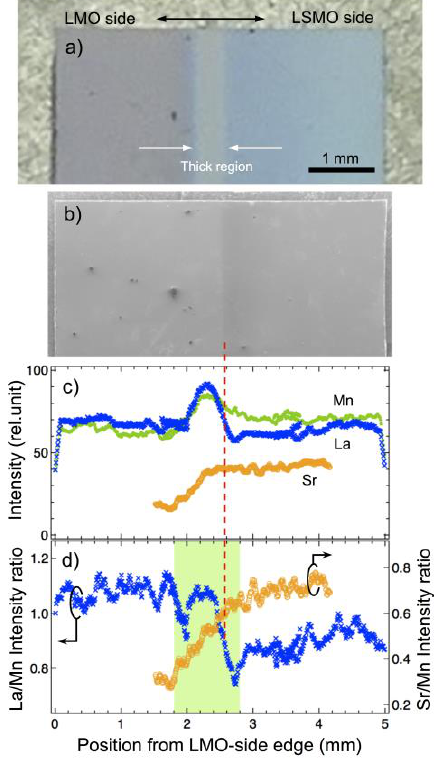
Figure 5. Optical image ( a ), SEM image ( b ), calibrated EDX signals of La, Sr, and Mn ( c ), and the EDX signals intensity ratio of La / Mn (crosses) and Sr / Mn (circles) ( d ) of a (1 − x )LaMnO 3 —x La 0.6 Sr 0.4 MnO 3 film. All panels are aligned so that the horizontal position in the images and the horizontal axes values in the graphs correspond to each other. Dashed line represents the position of the contrast boundary in the SEM image (Figure 5b). Colored area in Figure 5d represents the supposed compositionally-graded region.